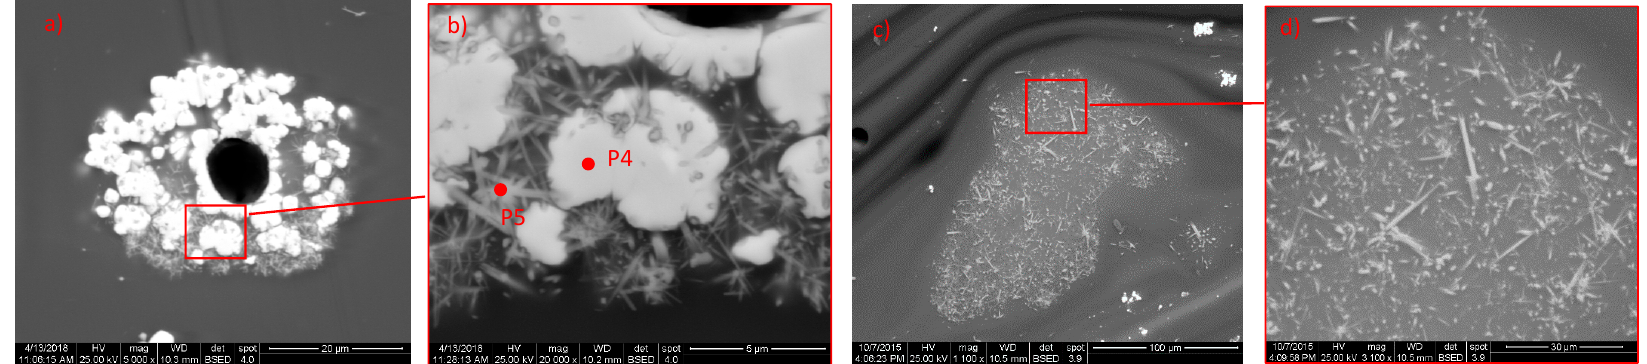
Figure 31. Mixed clusters made of micrometric subhedral and thin, sub-micrometric acicular crystals, also found in the matrices ( a , b ); clusters only made of acicular crystals ( c , d ), mainly found in green-colored glasses (DMS_1Ab green natron-based Egypt I glass tessera from the Great Mosque of Damascus, Syria—unpublished data [24,25]).